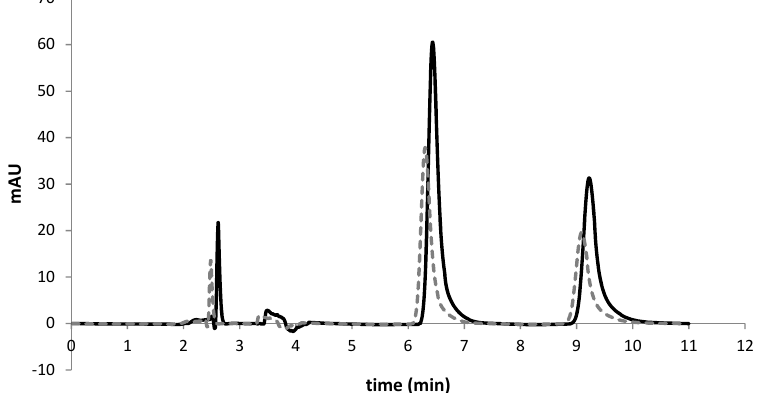
Figure 4. Chromatograms obtained from HPLC‐UV after analysis of 50ng/ ml standard solution. The dotted lines indicates the non‐modified adsotbant and the line shows the concentration of the analyte after the modification of the adsorbant using n‐Octyl